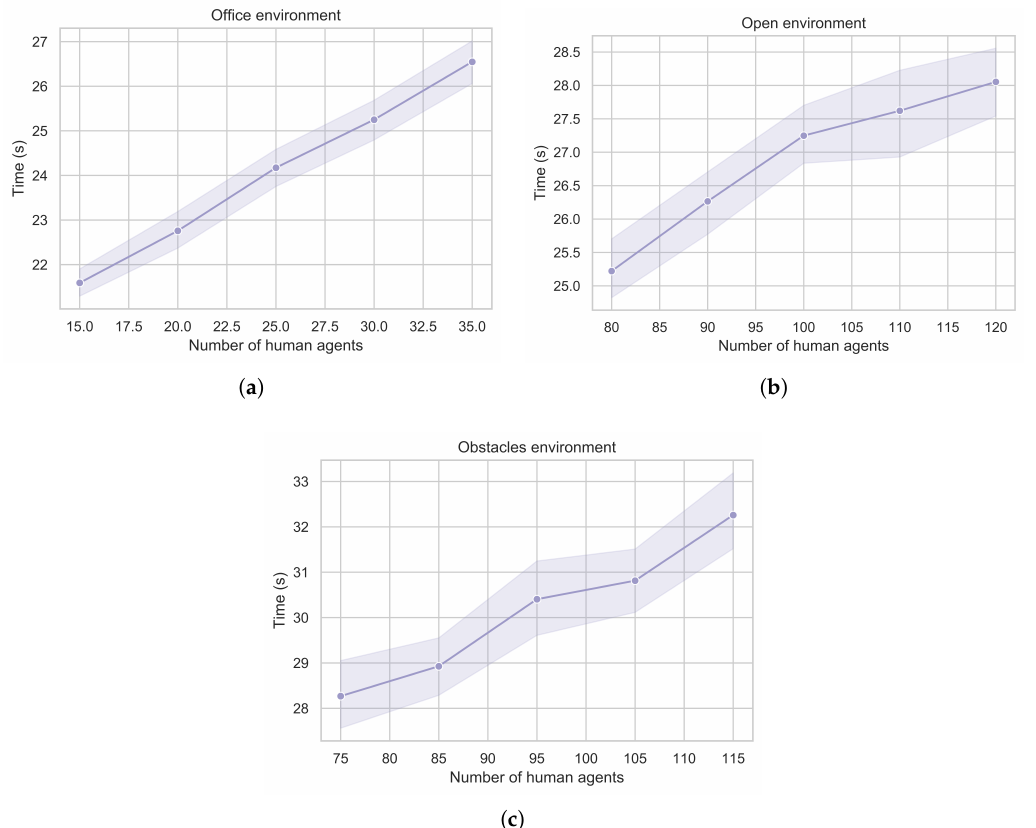
Figure 6. Mean and 95% confidence intervals (shaded area) of the time to completion in the ( a ) office, ( b ) open and ( c ) obstacles environment as a function of number of human agents in the environment for robots with full knowledge of the environment. In most cases, these are not significantly different from performances with a sensor range of 30 reported in Figure 4. Details of how this optimal performance compares with limited sensors are reported in Table